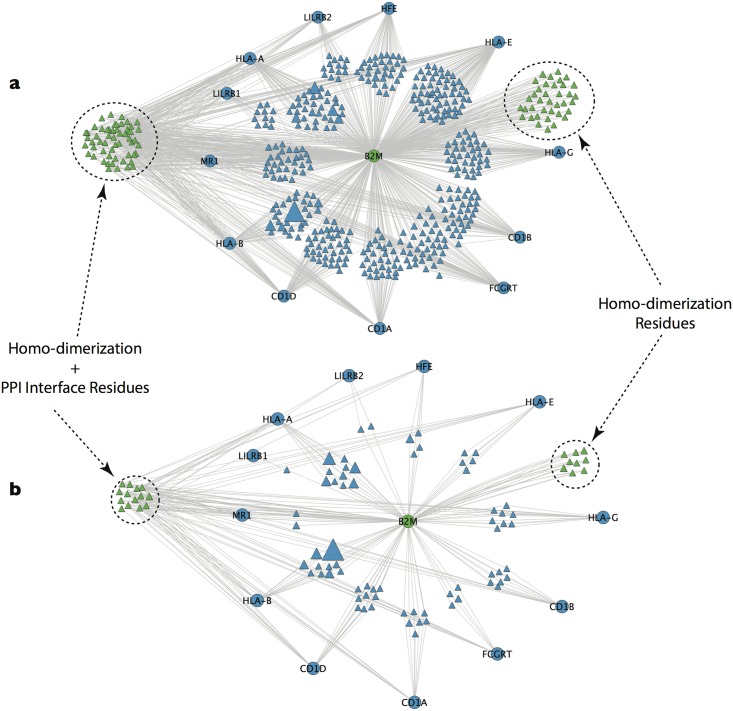
Bipartite B2M interaction networks.a) A bipartite network of the tumor suppressor B2M, its partners and the interface residues by which they interact. b) A bipartite network showing only the subset of residues that were observed to harbor missense mutations in cancer patients. The size here of the residue nodes represent the number of tumors in which the residue was mutated.